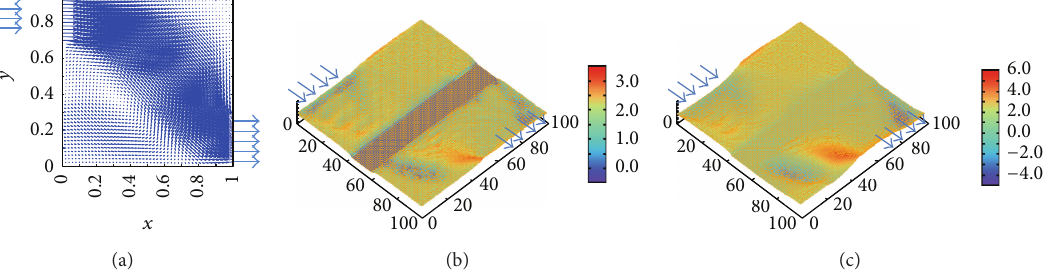
Figure 9: The sand ripples formation under the highway model. (a) Air velocity distribution; (b) and (c) are sand bed morphology at 20th and 100th